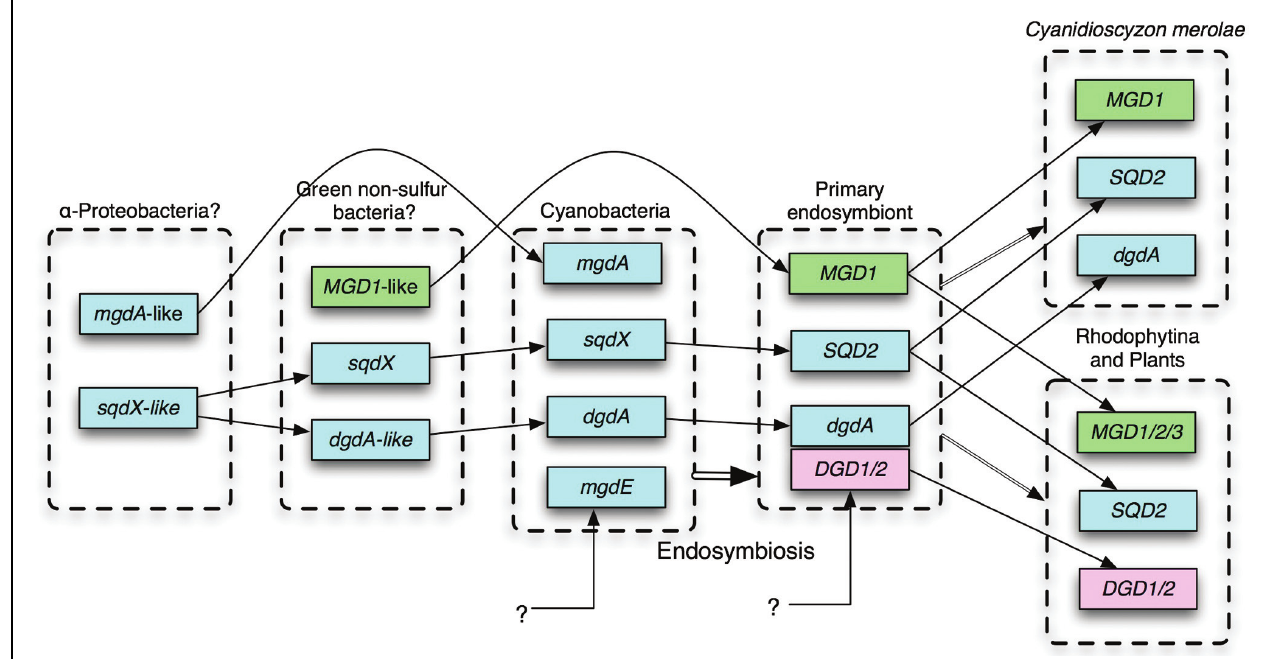
FIGURE 2 | Probable evolutionary scenario of glycolipid biosynthesis enzymes. For details, see text. Cyan, genes identified in cyanobacteria; green, originated from green non-sulfur (GNS) bacteria; pink, unknown eukaryotic origin.